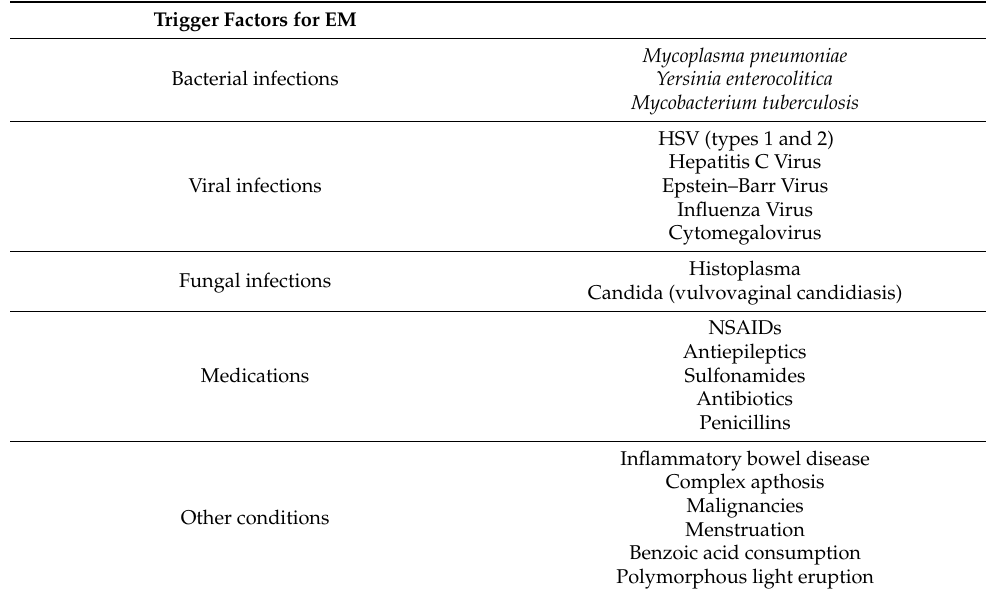
Table 1. A summary of the well-documented trigger factors for Erythema multiforme identified in Sokumbi et al. and Huff et al.